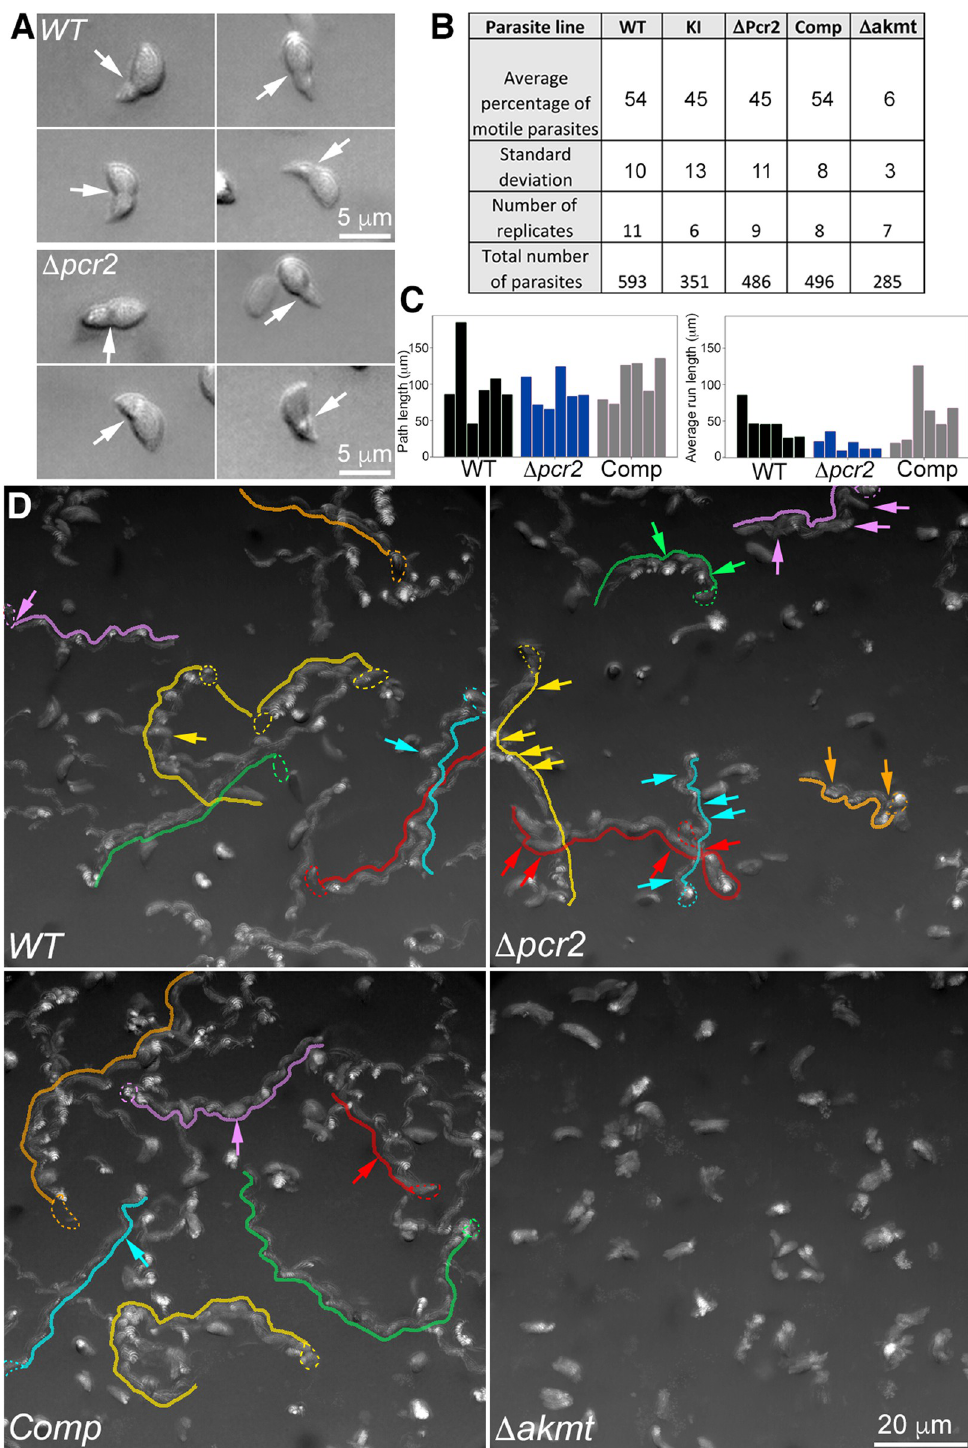
Fig 7. The Δ pcr2 parasite moves spasmodically in Matrigel. A. Four examples each of wild-type and Δ pcr2 parasites that displayed constriction during movement in 50% Matrigel. B. Table showing percentage of motile RH Δ hx Δ ku80 ( WT) , mE-Pcr2 Knock-in (KI), Δ pcr2 , complemented (Comp), and Δ akmt parasites in the 3-D motility assay. C. Bar graphs that show the path length and average run length of the trajectories highlighted in D. Average run length is calculated by dividing the path length by the number of runs within each trajectory. The number of runs is defined as 1+ number of